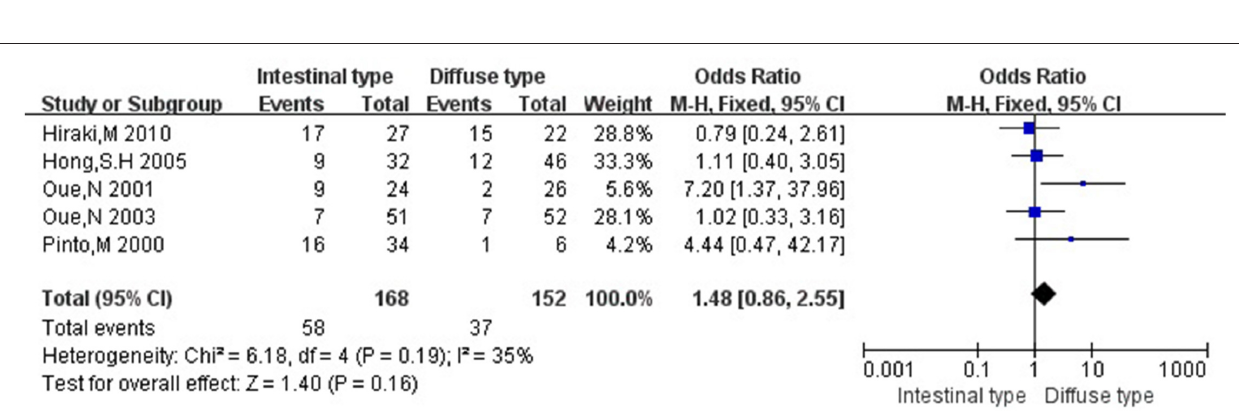
FIGURE 5 | Forest plot concerning hMLH1 methylation and Lauren classification. Fixed-effect model was used.